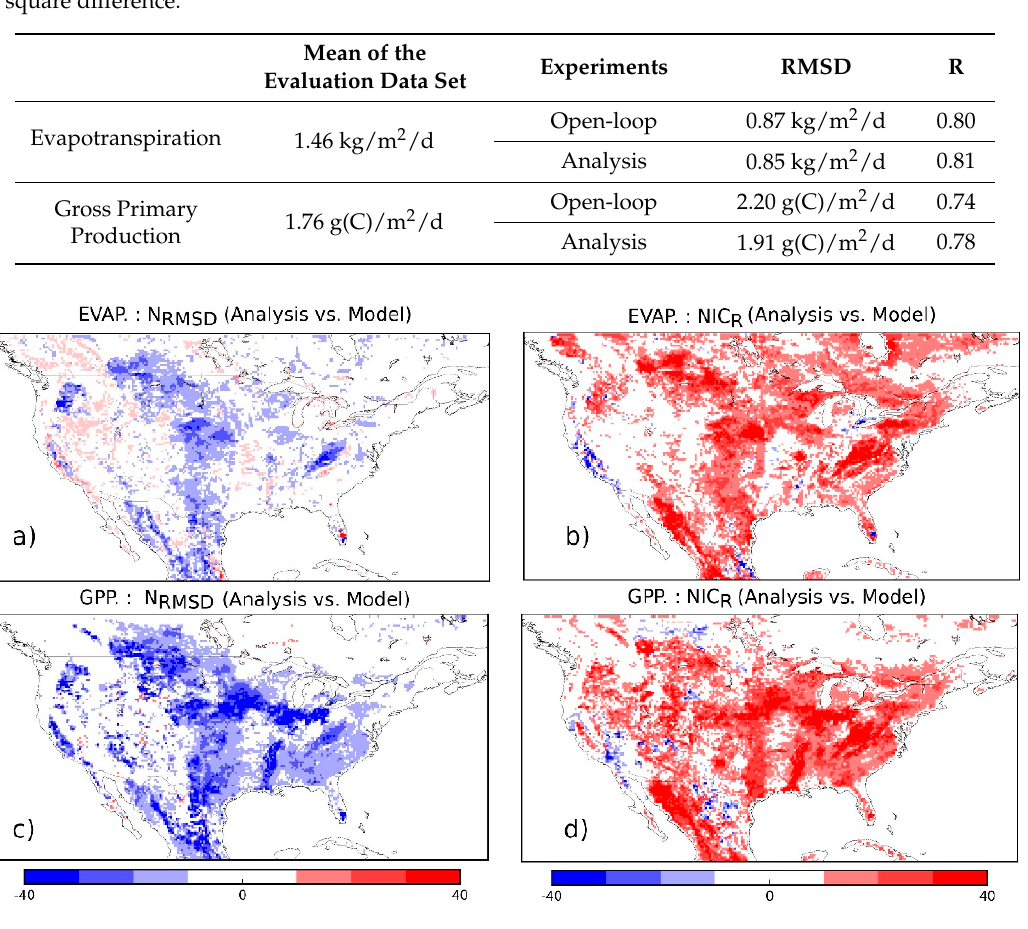
Figure 6. Top row: ( a ) normalized root mean square difference (RMSD) (blue colours indicate an improvement) and ( b ) normalized information contribution (NIC) applied on correlations values (red colours indicate an improvement) for evapotranspiration from the analysis with respect to the model. Bottom row: same as top row for gross primary production. Units are percentages.